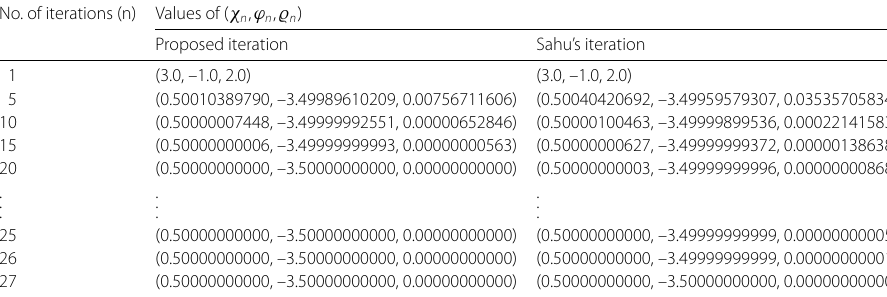
Table 2 Iterative values with starting point (3,–1,2)